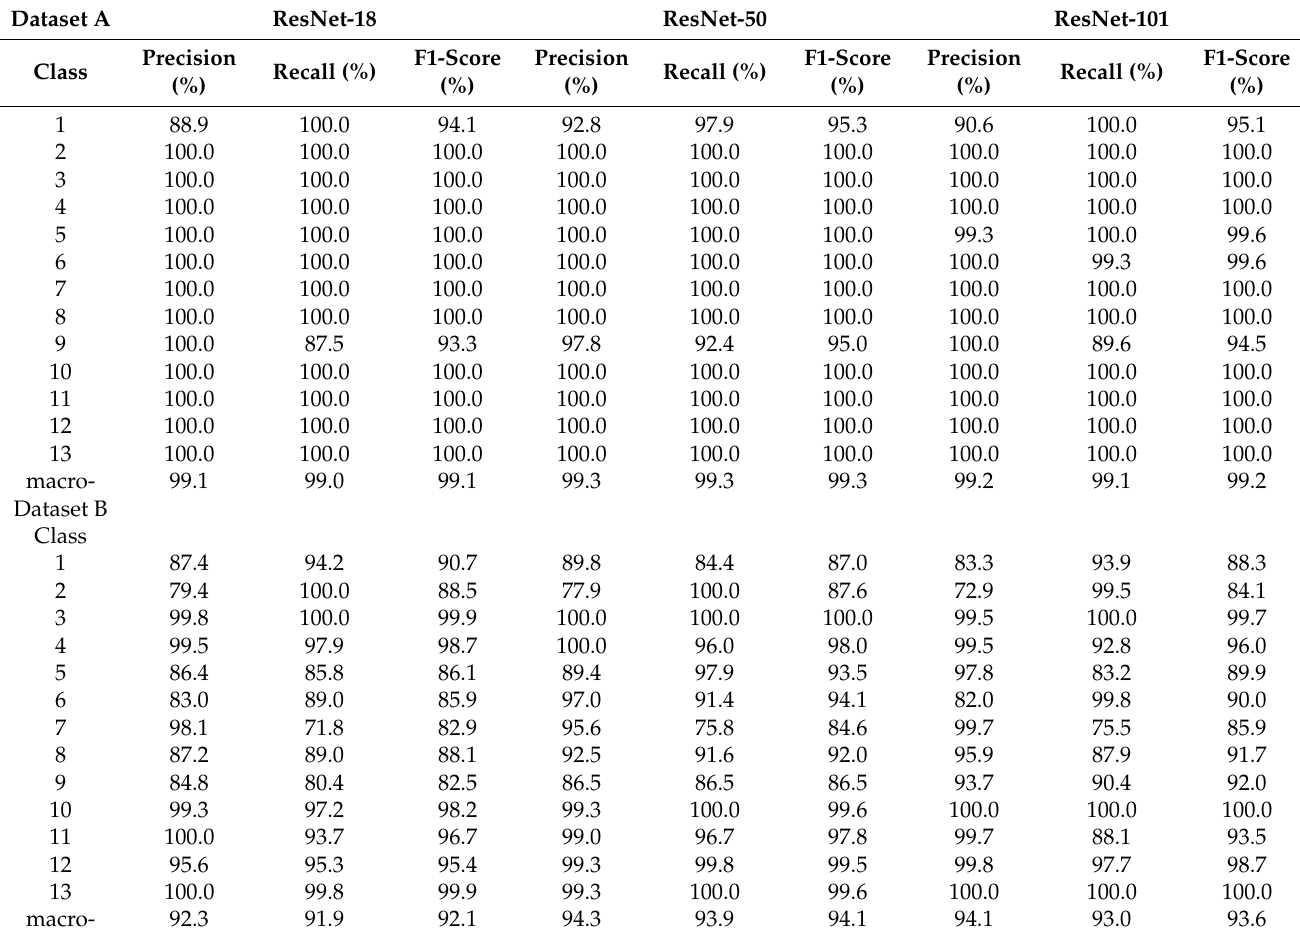
Table 4. Precision, recall, and F1-score of the three ResNet-based models on dataset A and dataset